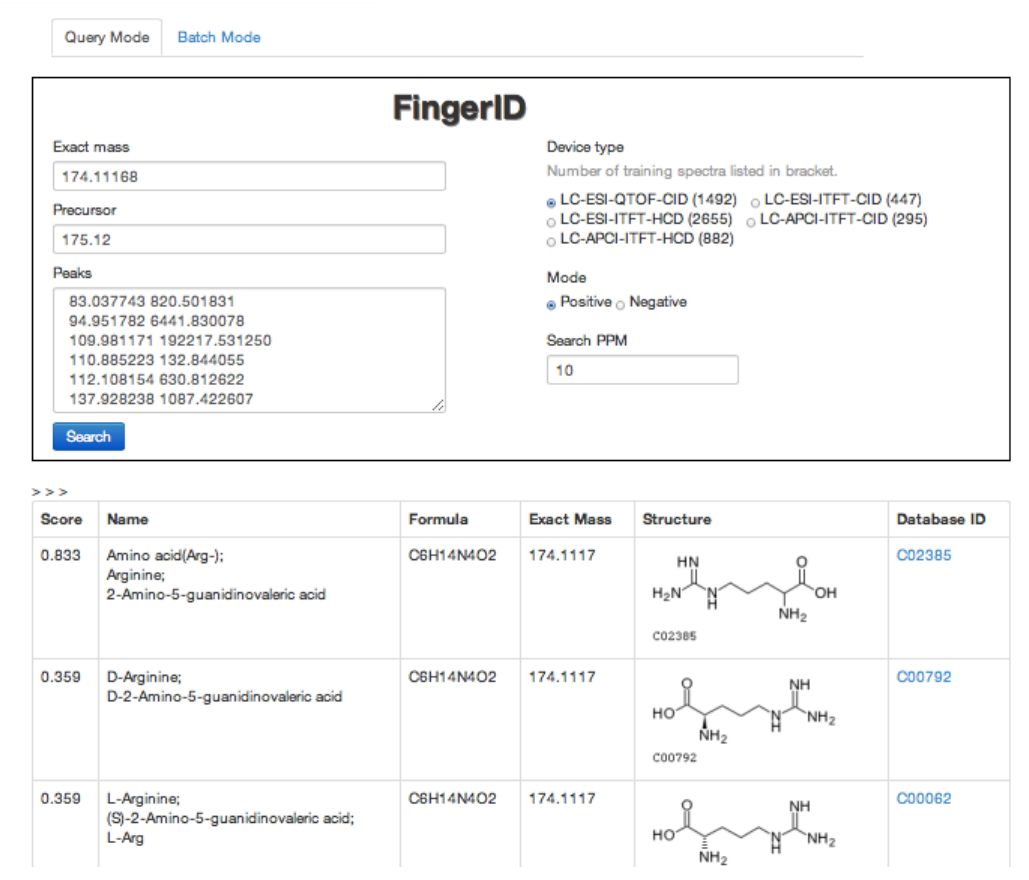
Figure 2. A screen-shot of FingerID web